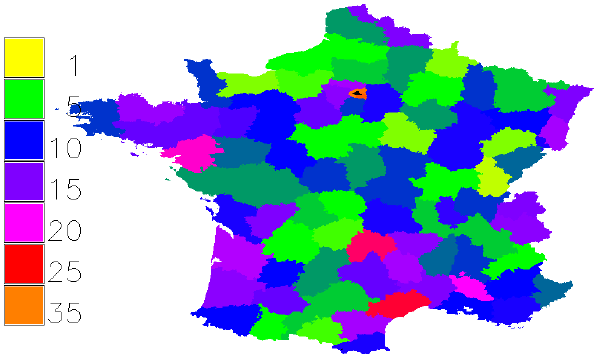
Fig. 10. Results of the comparison of ECOCLIMAP-II and AGRESTE for each French administrative department. Quantities Figure 10. Results of the comparison of ECOCLIMAP-II and AGRESTE for each French 9 plotted are cumulated errors (in percentage) for the six land use administrative department. Quantities plotted are cumulated errors (in percentage) for the six 10 types examined according to Eq. (2). land use types examined according to Eq. (2). 11